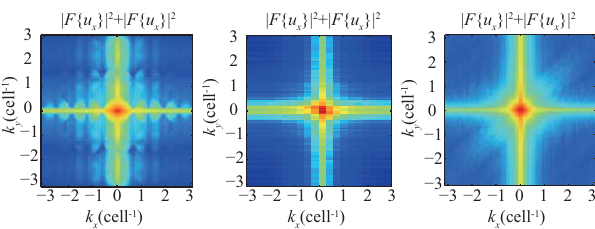
Fig. 4. The 2-D spectrum of original data (left), the template (mid- dle) and the filtered field (right). The spectrum is the squared sum of the 2-D Fourier spectrum of the vectors projected in the two di-